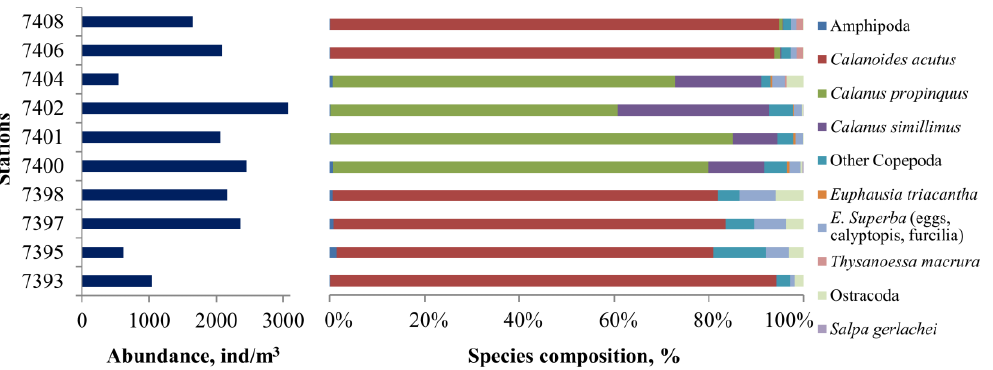
Figure 10. Contribution (%) of the major taxonomic groups to the total zooplankton abundance (ind/m 3